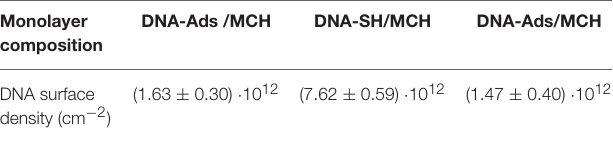
TABLE 2 | Surface densities of DNA oligonucleotides immobilized on the surface of gold disk electrodes ( n = 6). Monolayer